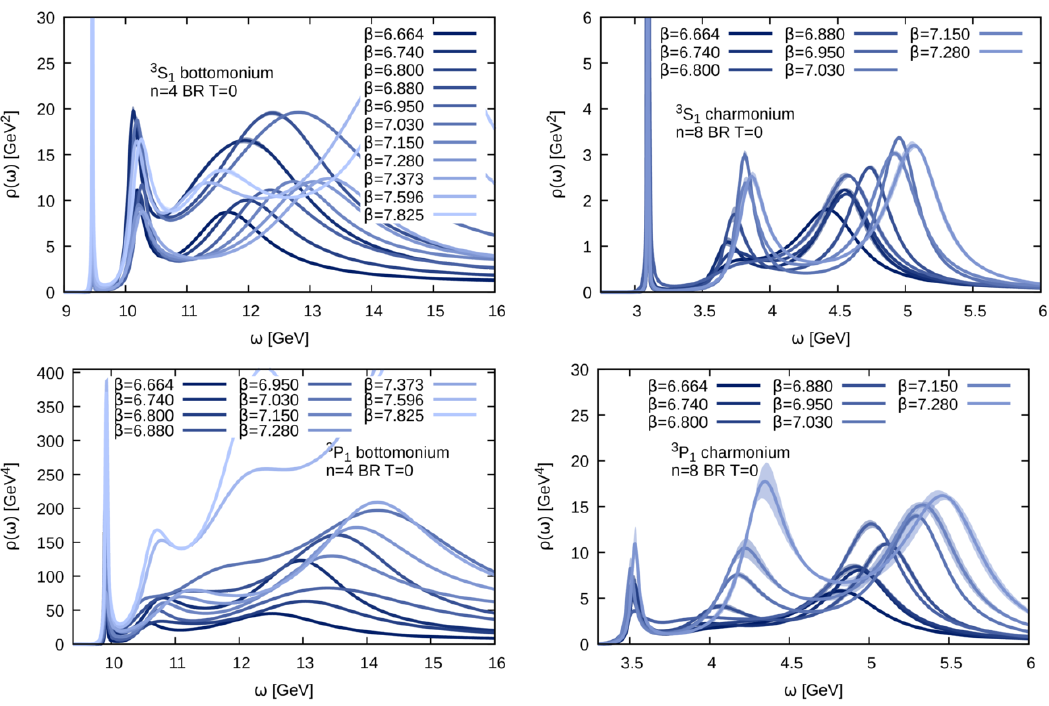
Figure 8 . Zero temperature reconstruction of bottomonium (left) and charmonium (right) spectral functions for di(cid:11)erent lattice spacings. The 3 S 1 S-wave channel (top) shows a very sharp ground state peak and at least for bottomonium also clear signs of the (cid:12)rst excited state, which in charmo- nium is less pronounced. The P-wave spectra in the 3 P 1 channel due to a lower signal to noise ratio show weaker but still clearly de(cid:12)ned signs of a ground state. The excited state structure remains un- resolved. Errorbands shown here only denote the statistical uncertainty from the ten-bin